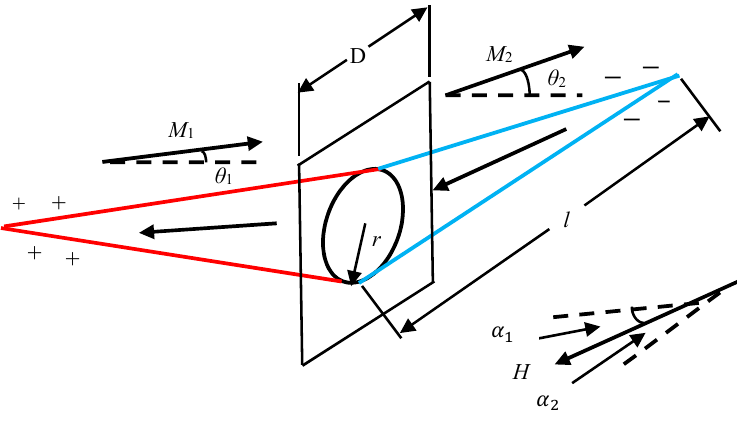
Figure 1. Nucleation model of a reverse domain at a grain boundary.